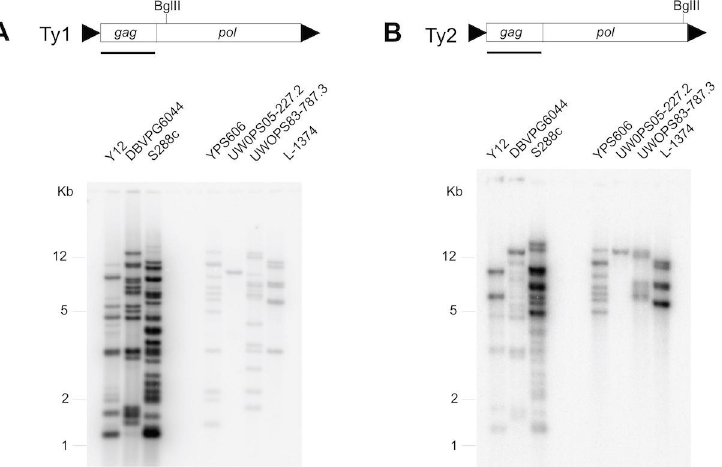
Fig 1. Southern blots of canonical Ty1-H3 and Ty2 gag hybridized to S . cerevisiae strains with Ty1-H3 mobility phenotypes. Southern blot results using radiolabeled ( A ) Ty1 and ( B ) Ty2 gag probes for S . cerevisiae strains with mobility data. Restrictive strains are shown on the left, and permissive strains are shown on the right of each Southern blot. Note that permissive strains typically contain weakly hybridizing bands to Ty1 below 5 kb in length that are not caused by cross-hybridization to Ty2. Schematics of the Ty1-H3 and Ty2-917 elements, respectively, showing the gag and pol open reading frames (rectangles) and LTRs (arrowheads) are shown above each Southern blot. The probes used for Southern blots were obtained from the gag gene of each element (underlined) and are 1,162 bp and 1,158 bp in length for Ty1-H3 and Ty2-917, respectively. The complete Ty1-H3 element is 5918 bp in length and the complete Ty2-917 element is 5960 bp in length. The locations of the BglII restriction sites within Ty1-H3 and Ty2-917 pol regions are shown above the schematics. Identical membranes with the same DNA samples were hybridized in panels (A) and